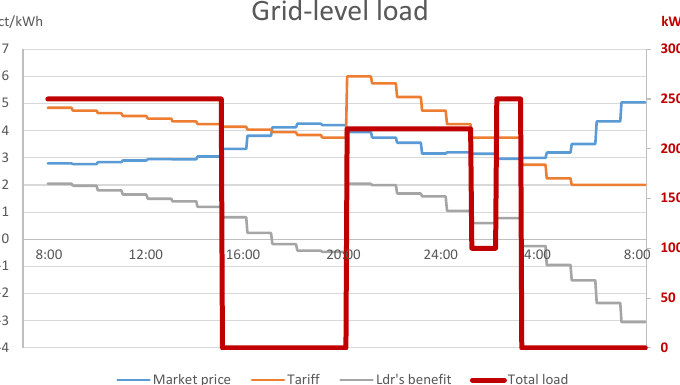
Figure 1. Optimistic bilevel solution: grid-level consumption.